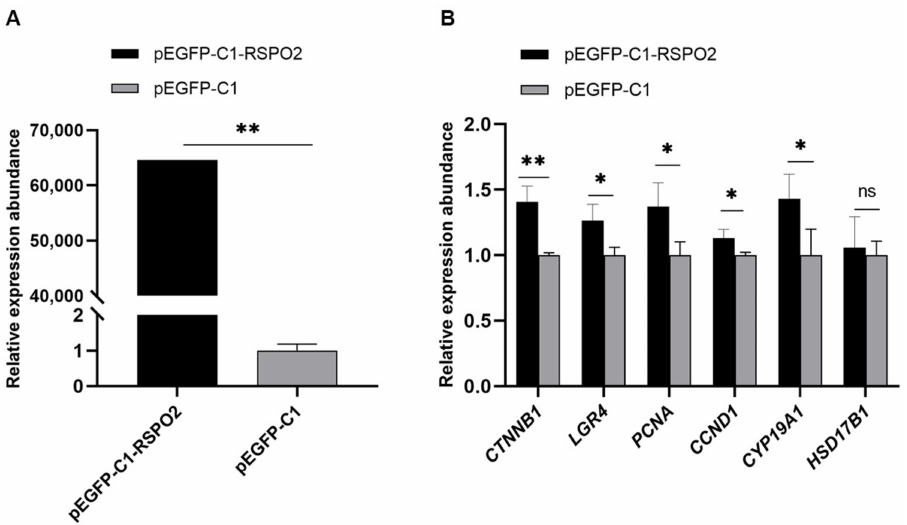
Figure 6. Regulation of RSPO2 gene on GCs. ( A ) RSPO2 overexpression efficiency validation. ( B ) Expression abundance of related genes. * Shows that there is a significant difference at the 0.05 level among groups, ** Indicates a significant difference at the 0.01 level. The genes to be tested were normalized using housekeeping genes, the relative expression abundance was expressed as 2 − ∆∆ Ct , and the results are shown as means ± SD ( N =